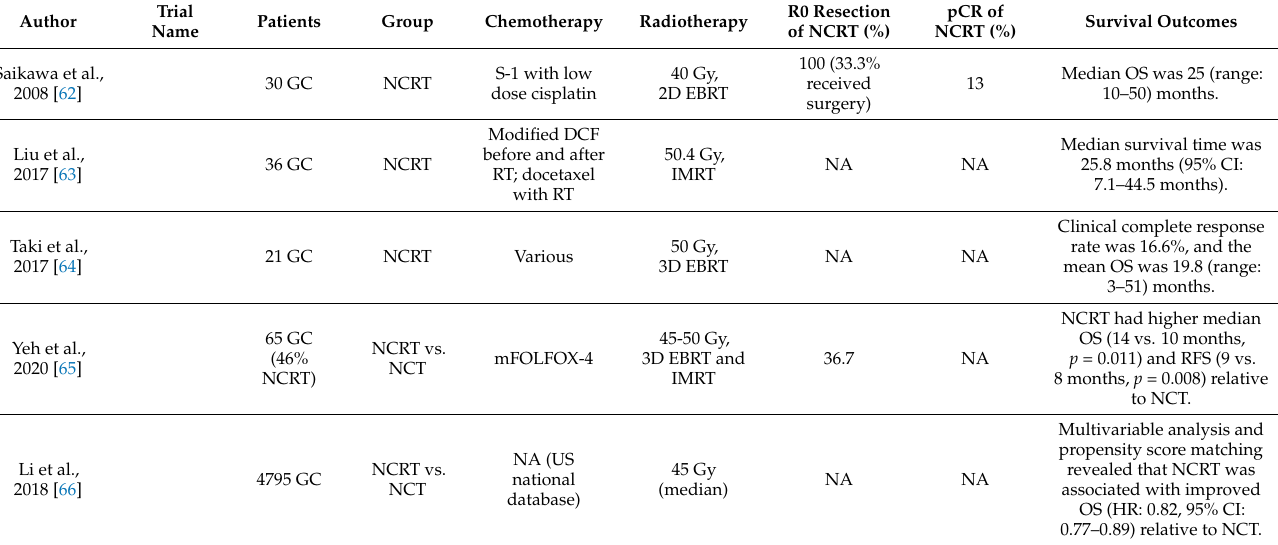
Table 4. Studies examining neoadjuvant chemoradiotherapy (NCRT) for unresectable gastric cancer